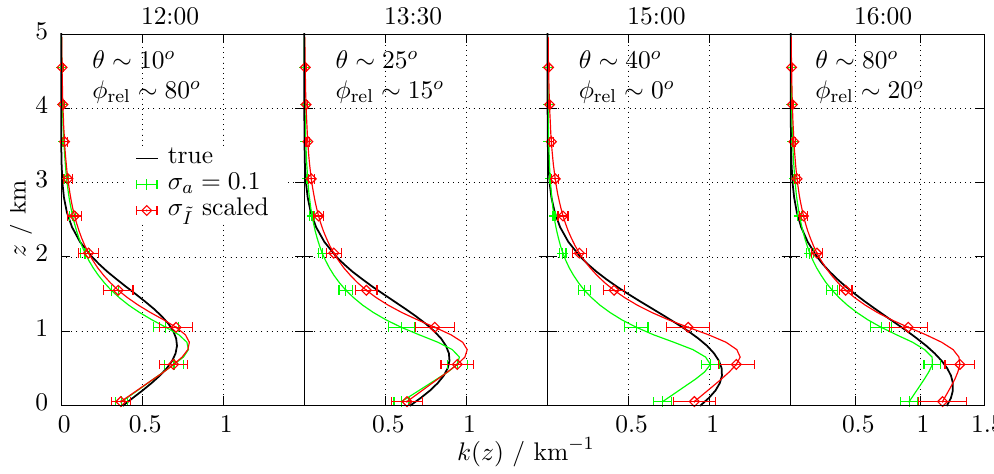
Fig. 17. Example for profiles retrieved as in Fig. 16 for φ rel < 90 ◦ (same